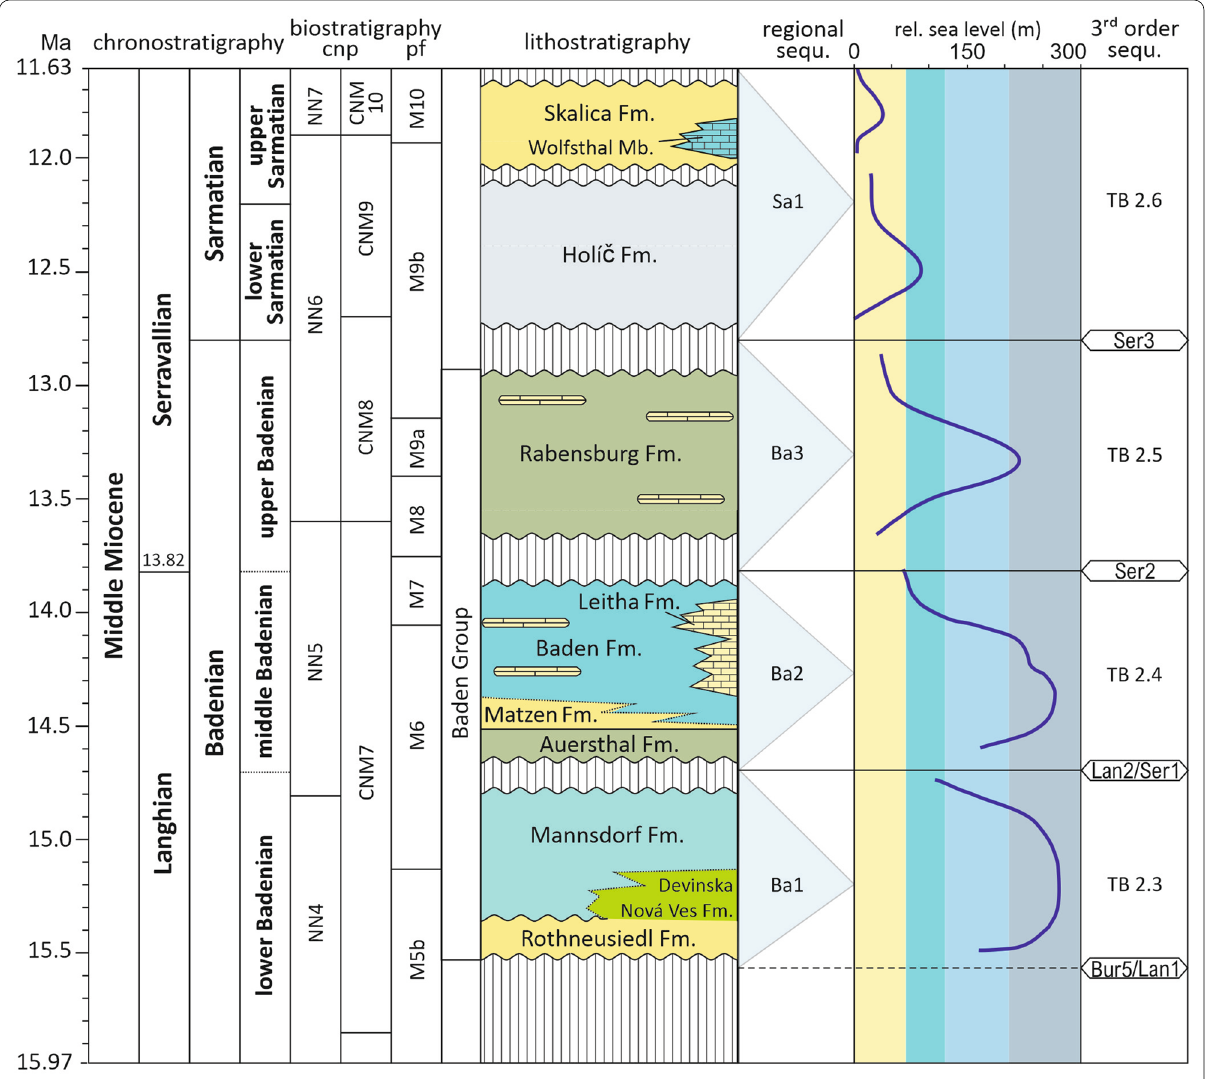
Fig. 1 Stratigraphic chart of the Middle Miocene following the International Stratigraphic Chart (https:// strat igrap hy. org/ chart) with the regional stages and substages of the Central Paratethys; the biostratigraphic columns show the calcareous nannoplankton (cnp) zonation after Martini (1971) (left) and after Backman et al. (2012) (right) and the planktic foraminiferal (pf) zonation after Wade et al. (2011); the lithostratigraphy follows Harzhauser et al. (2020), regional sequences after Strauss et al. (2006) and Siedl et al. (2020); the relative sea level indications in the Central Paratethys follow Kranner et al. (2021a) and the 3 rd order sequences Hardenbol et al.